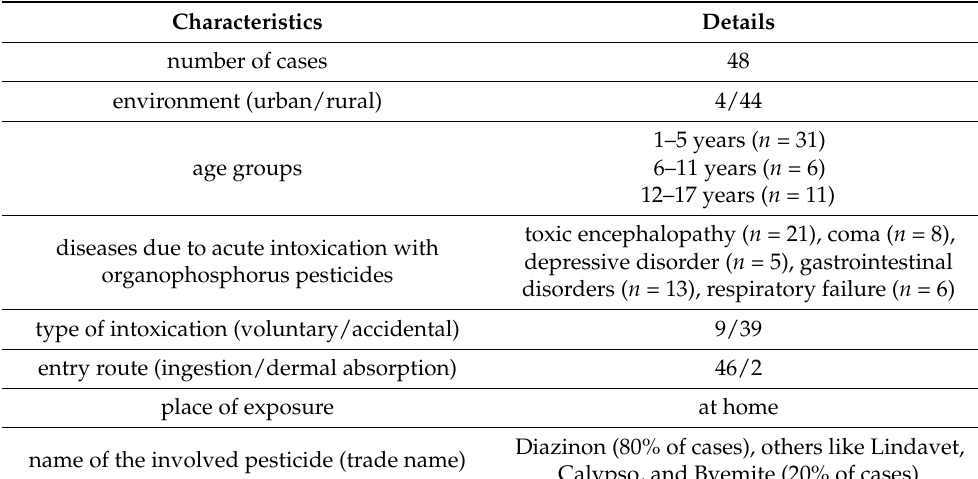
Table 1. Clinical and demographic characteristics of the investigated